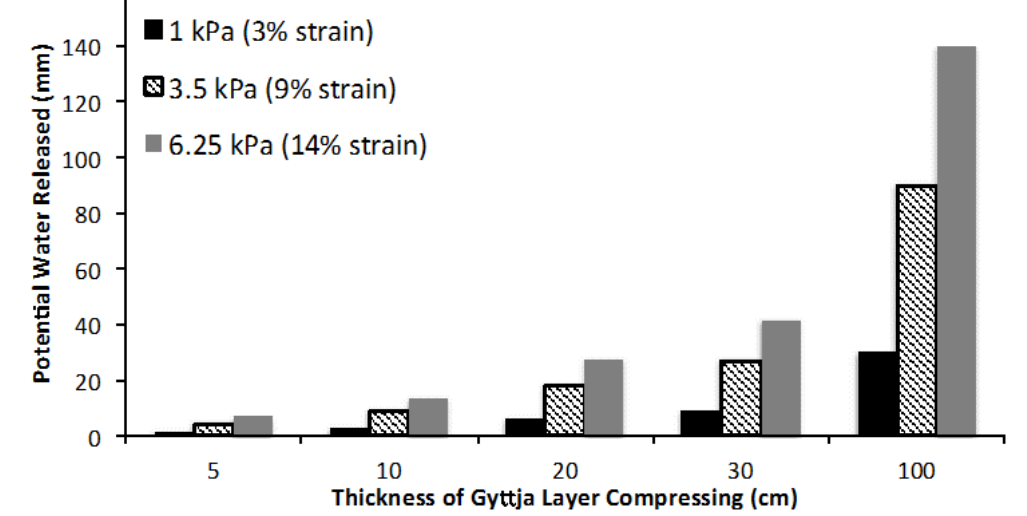
Figure 5. The potential amount of water that could be released from different thicknesses of consolidating gyttja under different